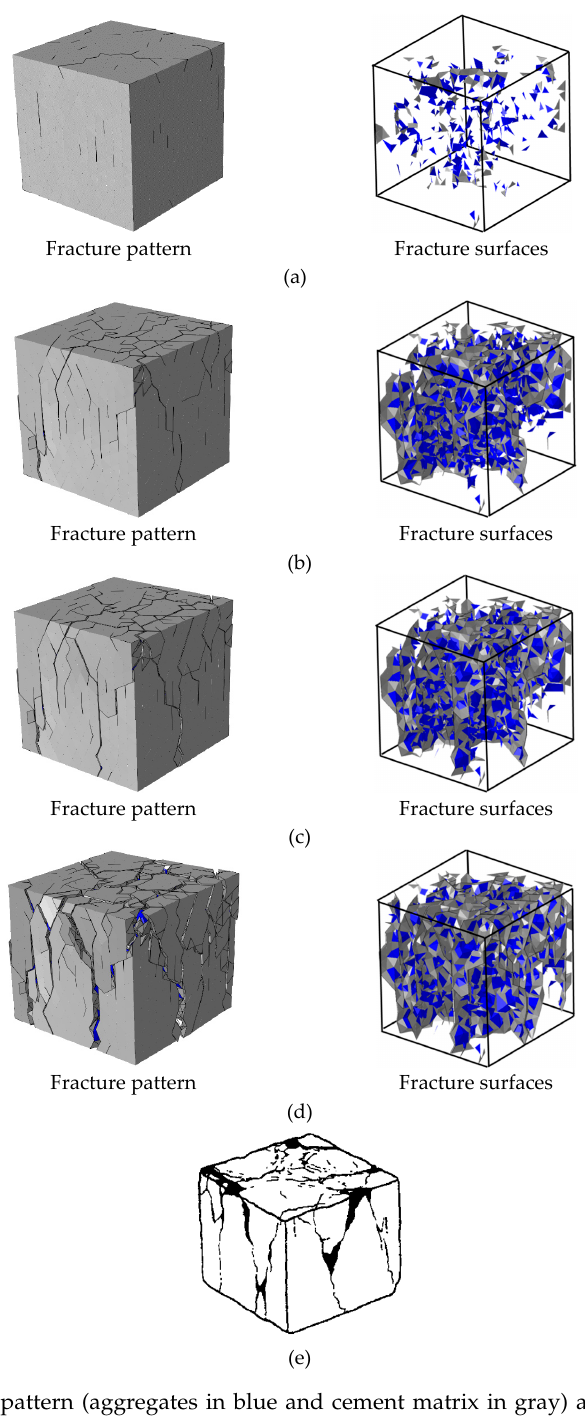
Figure 9. Average stress–strain curve of concrete under uniaxial compression in low- friction (LF) condition.